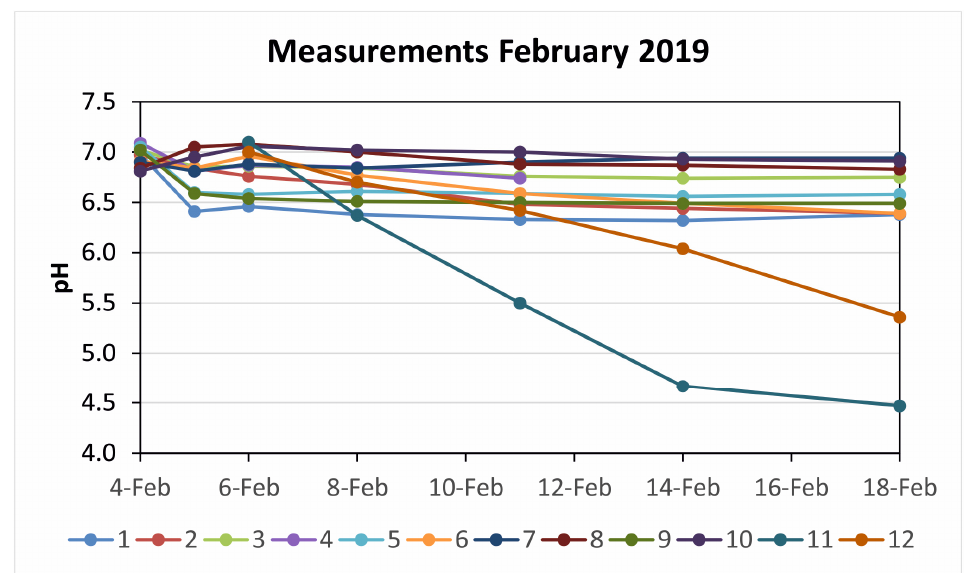
Figure 4. pH average results obtained during the evaluation carried out on February 2019. Numbers at the bottom of the X axis are the sensors numbers.